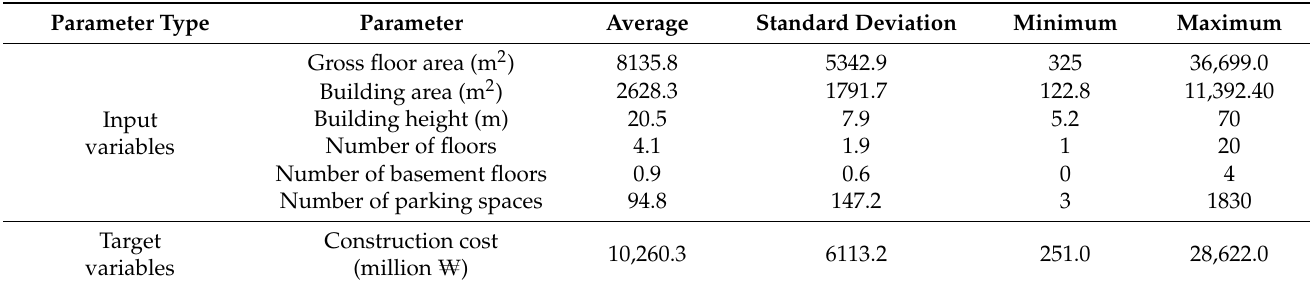
Table 1. Parameters and attributes for the input and target variables.